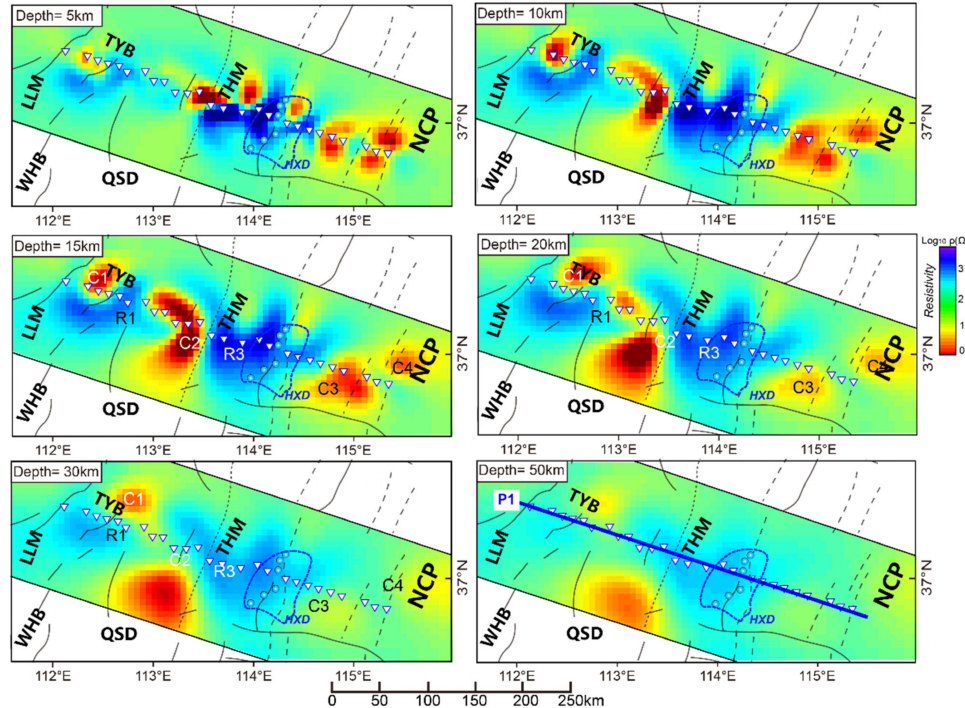
Figure 4. Horizontal slices of 3D inversion model at depths of 5, 10, 20, 30 and40 km, respectively. The superposed tectonic features are the same as in Figure 1b. The white triangles demonstrate the locations of MT sites. Warm and cold colors indicate low and high resistivity.